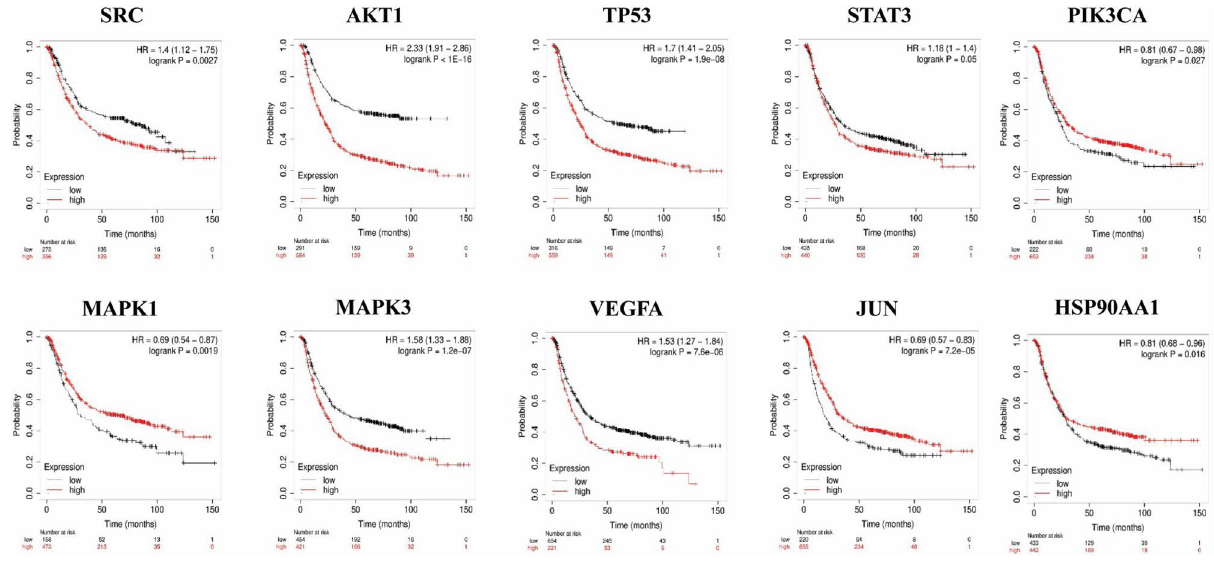
Figure 9. Kaplan–Meier overall survival analyses of patients with gastric cancer based on expression of the ten hub genes. HR, hazard ratio (http:// kmplot. com/ analy sis/ index. php?p= servi